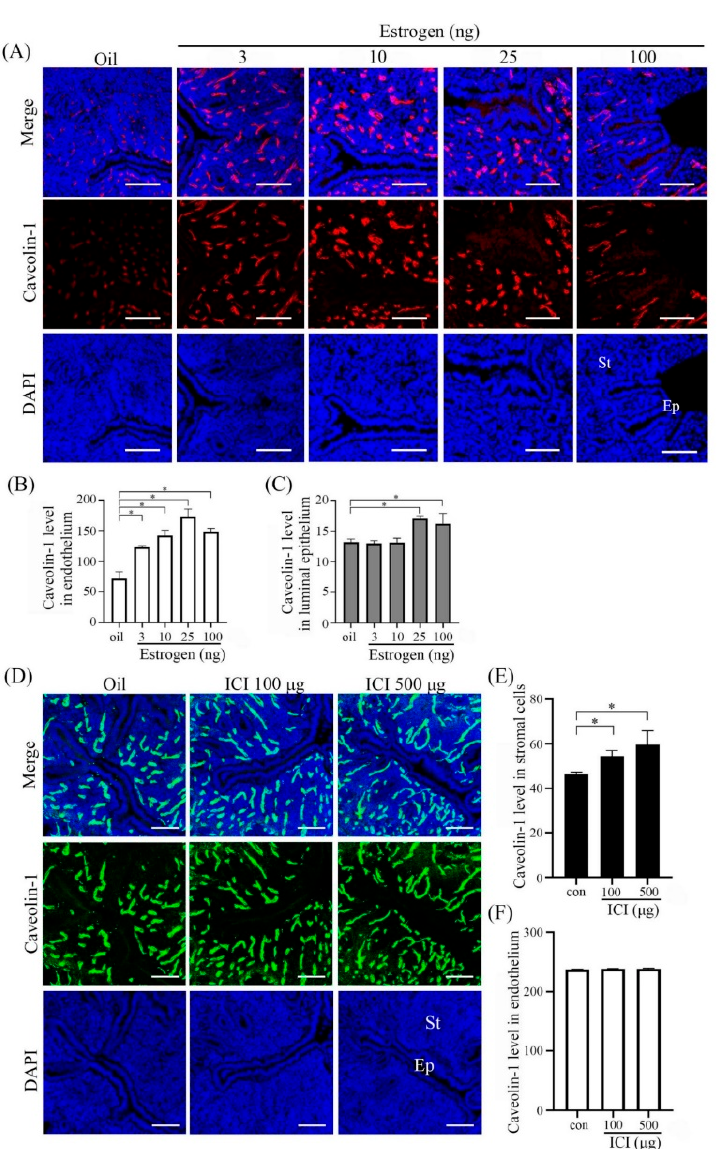
Figure 3. Caveolin-1 immunofluorescence in estrogen-treated uteri of ovariectomized mice. ( A ) Mouse uteri treated with different doses of estradiol-17 β for 12 h. ( B ) Semi-quantitative Caveolin-1 level in endothelium in ( A ). ( C ) Semi-quantitative Caveolin-1 level in luminal epithelial cells in ( A ). ( D ) Mouse uteri treated with different doses of ICI 182,780 (ICI) for 12 h. ( E ) Semi-quantitative Caveolin-1 level in endometrial stromal cells in ( D ). ( F ) Semi-quantitative Caveolin-1 level in endothe- lium in ( D ). Five mice per group. St, stromal cells; Ep, epithelium; *, p < 0.05; Scale bar = 100 µ m. To further verify the dependency of Caveolin-1 expression on estrogen receptor, we examined Caveolin-1 expression in estrogen receptor α (ER α ) -deficient mice. In wild-type mouse uteri, there were strong signals in endothelial cells and weak signals in epithelial cells and stromal cells (Figure 4A). In ER α -deficient mice, Caveolin-1 signals in stromal cells were significantly stimulated compared with wild-type mice (Figure 4B), but the level of Caveolin-1 in endothelium had no significant difference (Figure 4C). Caveolin-1 signals in stromal cells were further suppressed by PPT (Figure 4D,E), an ER α agonist. When ovariectomized mice were treated with Diarylpropionitrile (DPN), an ER β agonist, DPN had no detectable effect on Caveolin-1 level (Figure D,F).